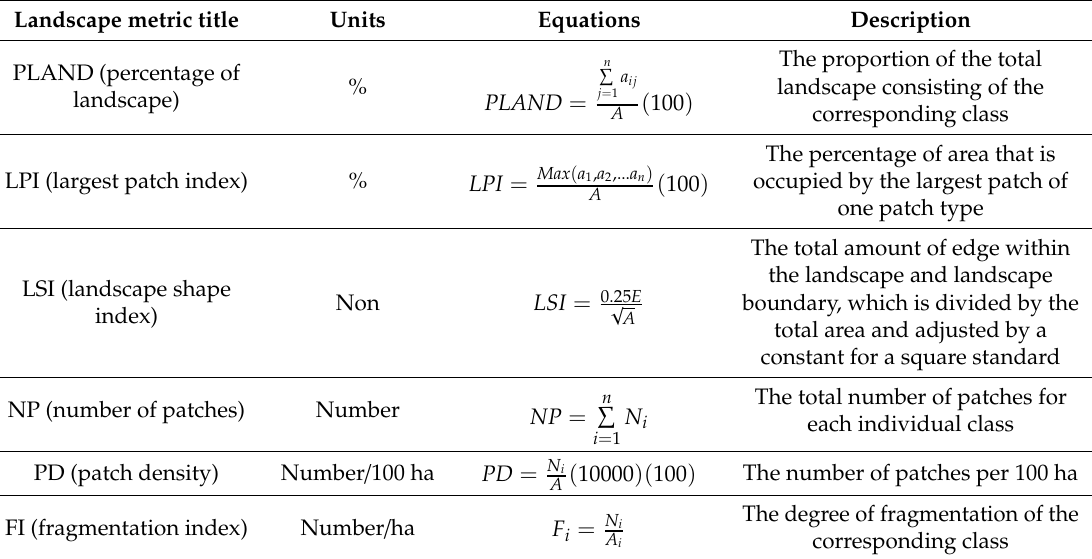
Table 4. The landscape metrics that were applied in the present study.